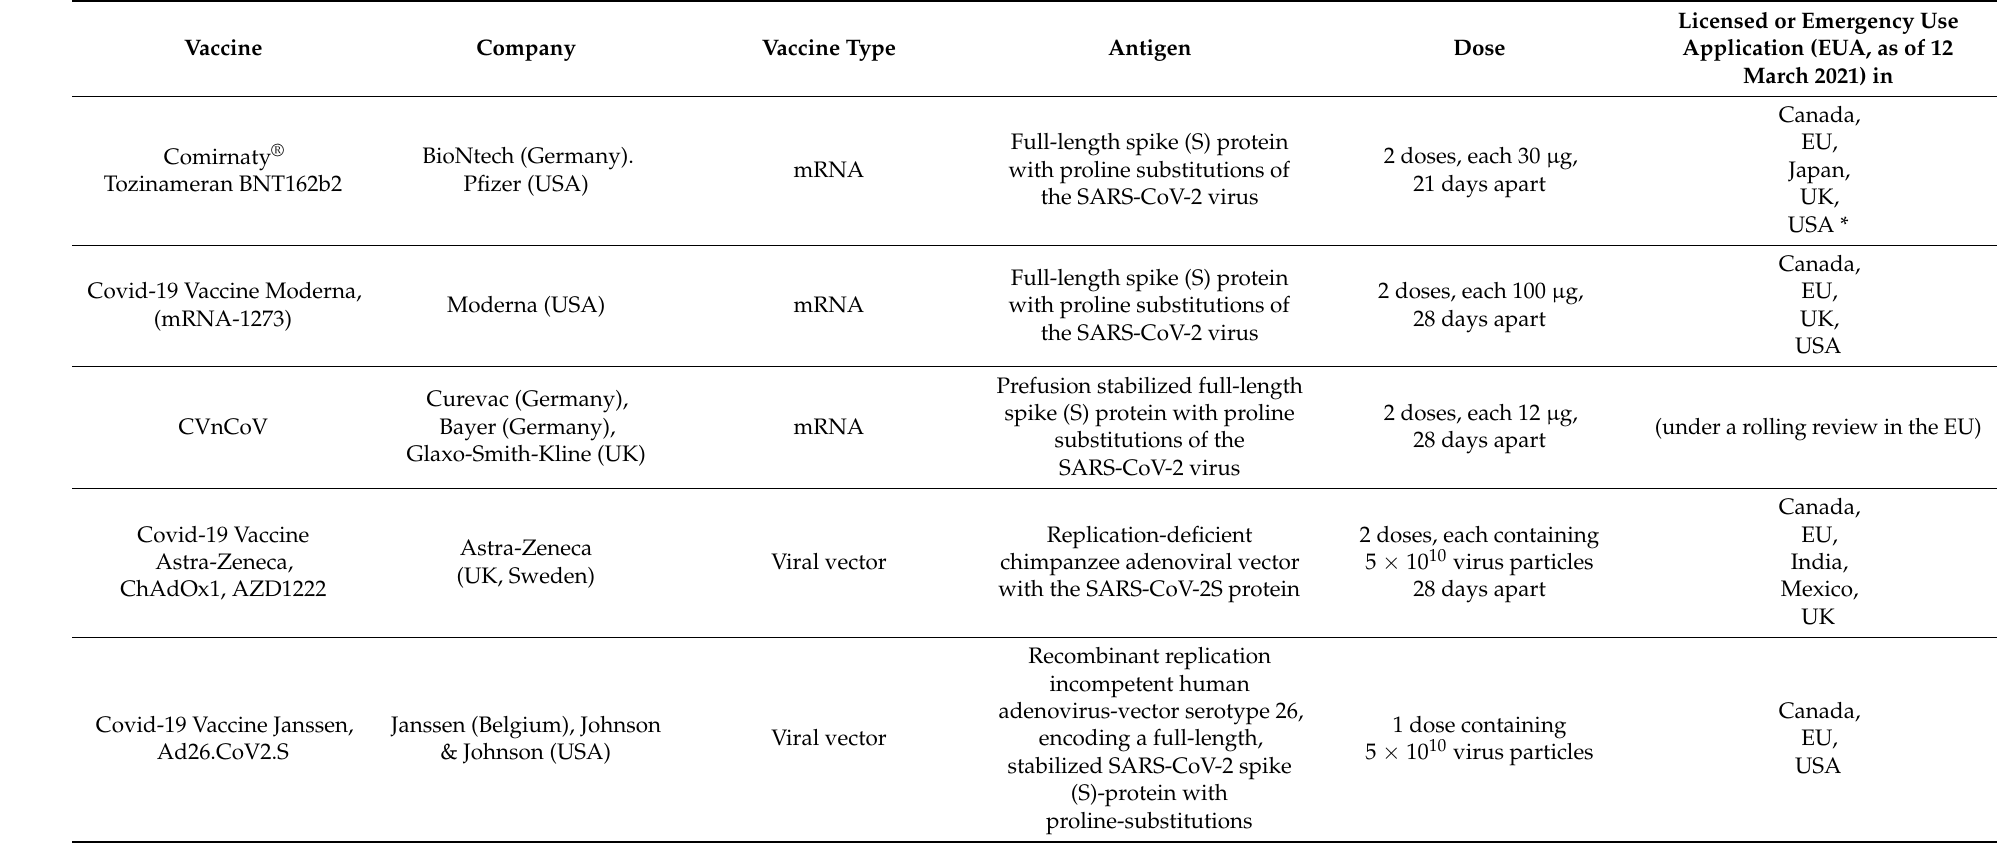
Table 1. SARS-CoV-2 vaccines developed and currently under emergency use application, modified from and, for more details, see